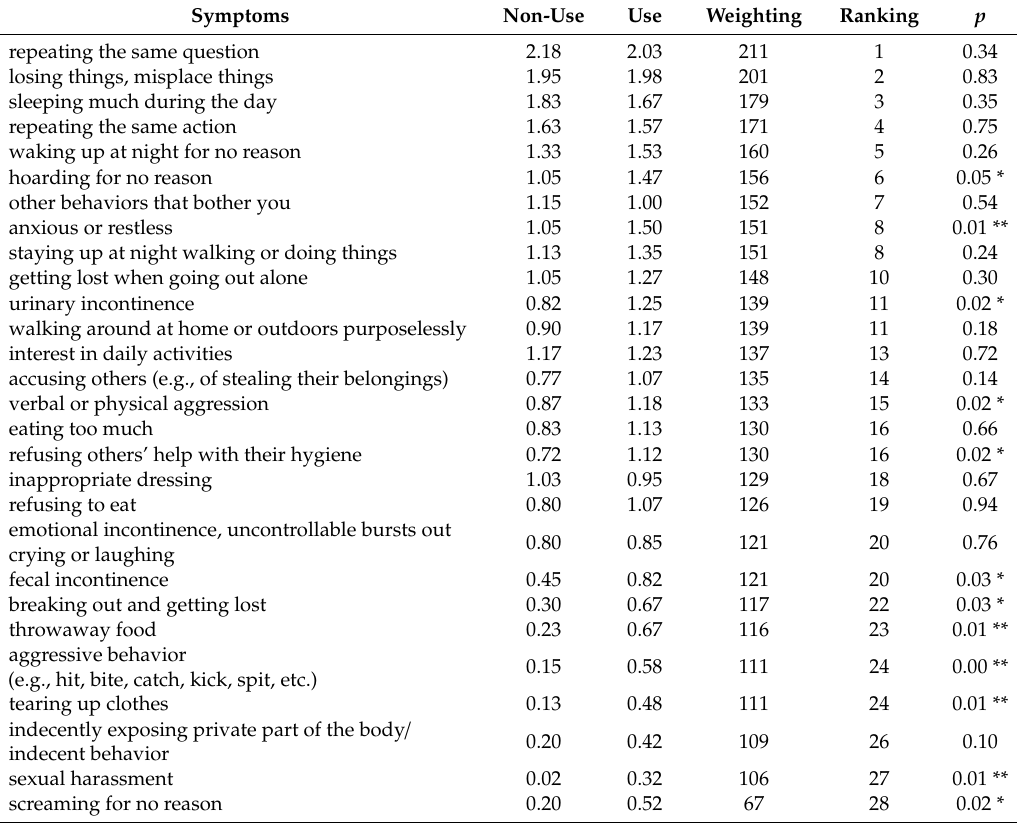
Table 3. Frequency ranking of psychological symptoms of dementia (BPSD) in patients with dementia (PWD) and di ff erences between BPSD-related use and non-use of care resources. Symptoms Non-Use Weighting